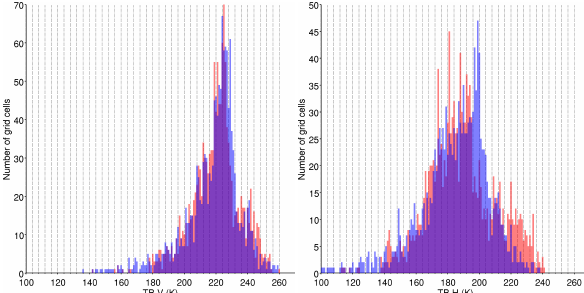
Fig. 3. Distributions of TB V (left) and TB H (right) observed over the GIS by radiometer 3 during the first week of January 2013 (red) and July 2013 (blue).